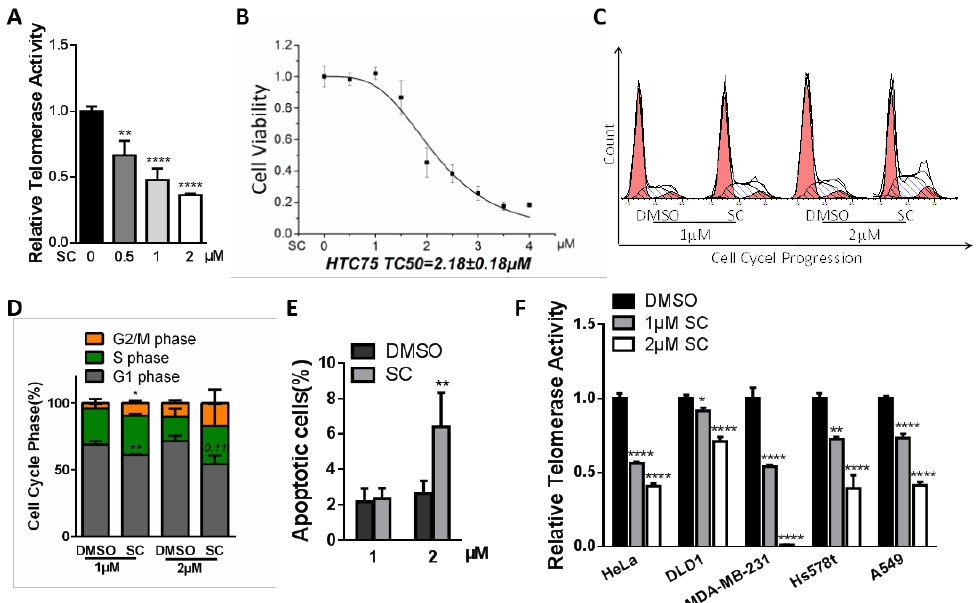
Figure 2. Effects of SC treatment on different cancer cells. ( A ) The inhibitory effect of SC on telomerase activity in HTC75 cells was evaluated. The relative telomerase activity (RTA) level suggested a dose-dependent suppressive effect. ( B ) The CCK-8 assay showed the cell viability curve of SC in HTC75 cells. The median toxic concentration (TC50) was 2.18 μM. ( C ) Cell cycle analysis through PI staining and the following flow cytometry for HTC75 cell treated with SC. ( D ) Quantification of cell cycle populations measured in ( C ). ( E ) Quantification of apoptotic cells (Annexin-V FITC positive cells). ( F ) The 1 μM SC treatment for 48 h hinder ed RTA in multiple cancer cells, normalized by RTA of the DMSO group. All the analyses were performed on triplicate samples (* p < 0.05, ** p < 0.01, **** p < 0.0001).